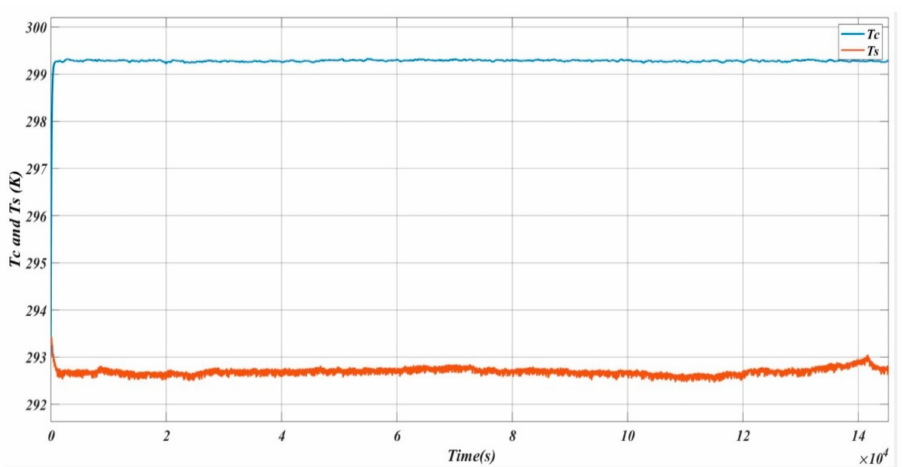
Figure 9. The plot of the estimated T c and measured T s .